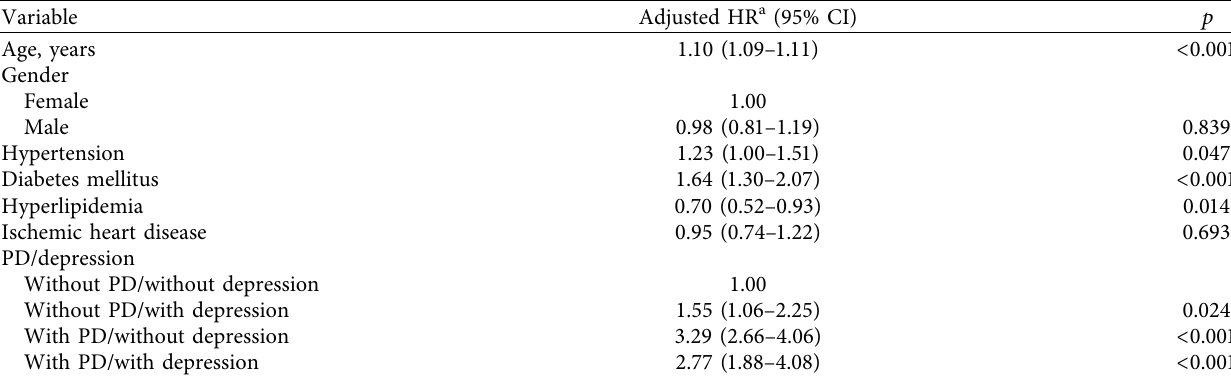
Table 2: Hazard ratio for dementia with different